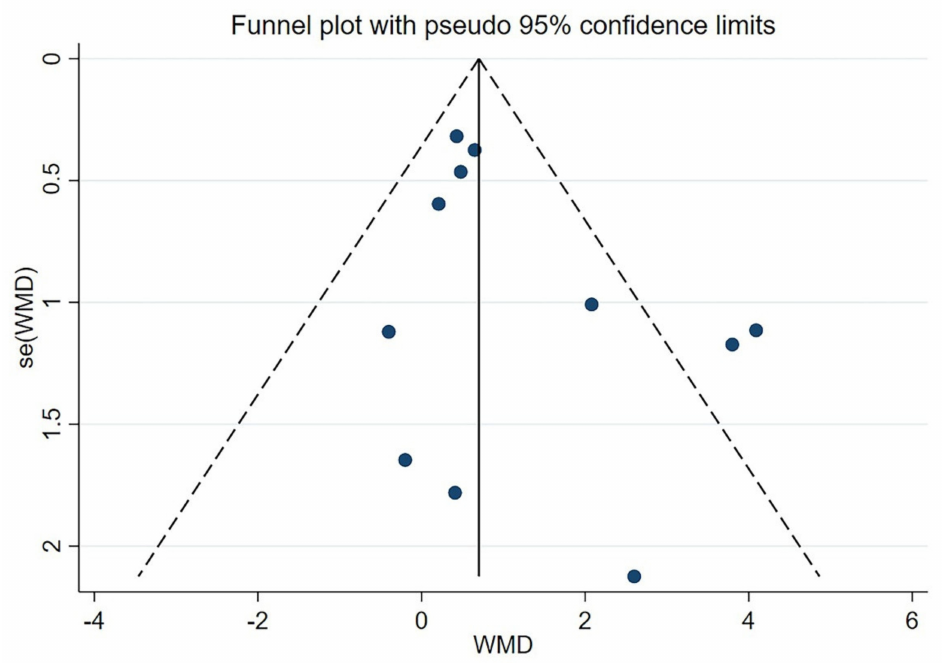
Figure 5. Funnel plot of